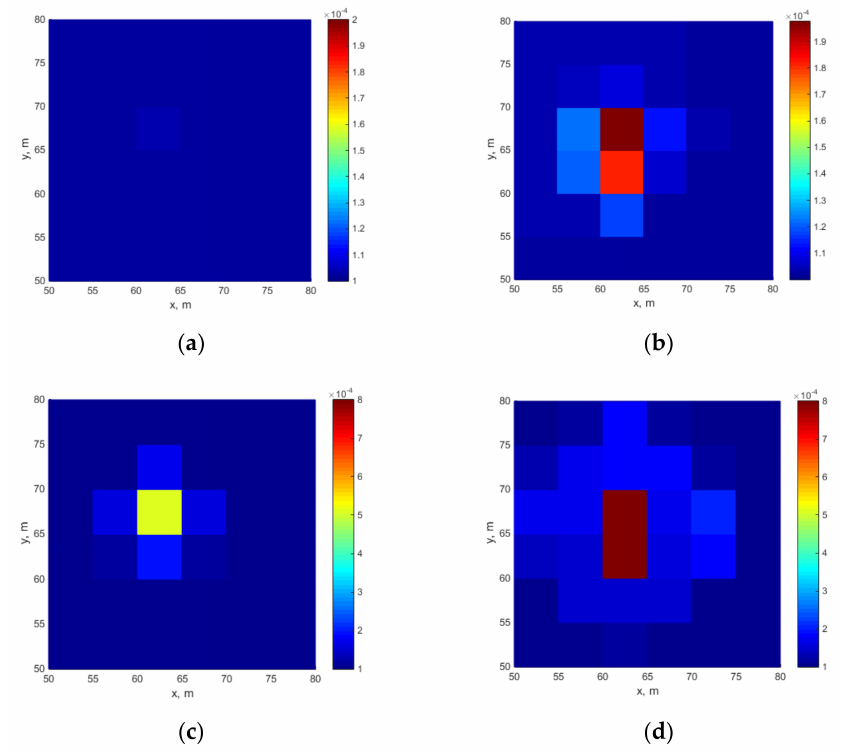
Figure 12. Profiles of the calculated oil saturation: ( a ) 400 days, upper layer; ( b ) 800 days, upper layer; ( c ) 400 days, lower layer; ( d ) 800 days, lower layer.